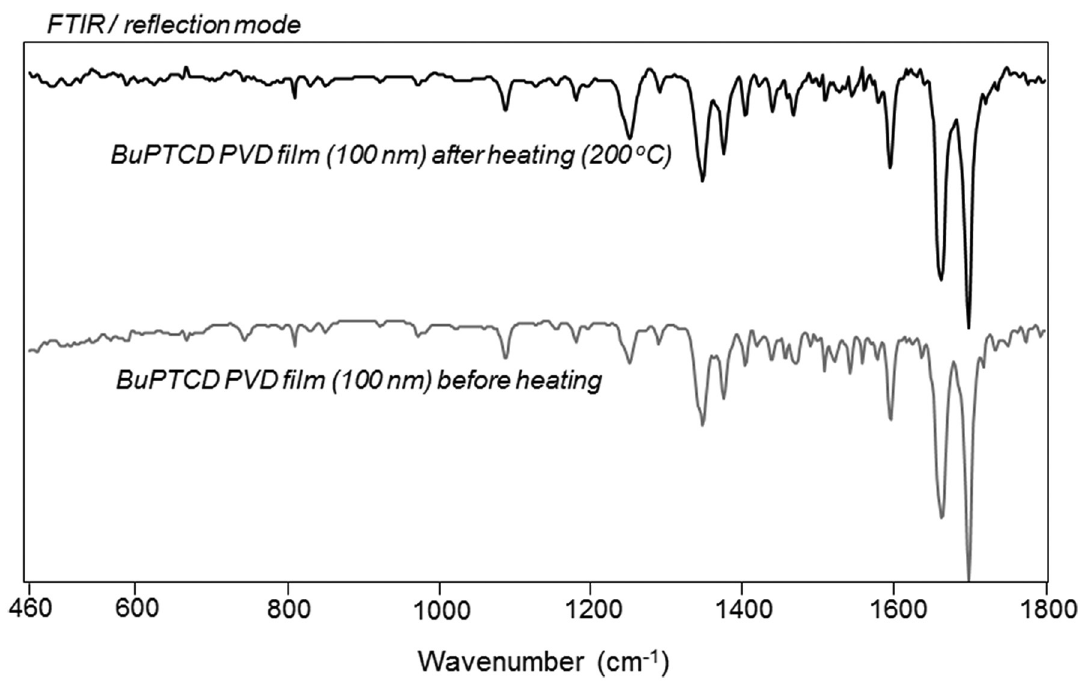
Figure 2S. FTIR spectra (reflection mode) recorded for the 100 nm PVD film of BuPTCD before and after annealing at 200 °C for 2 h.